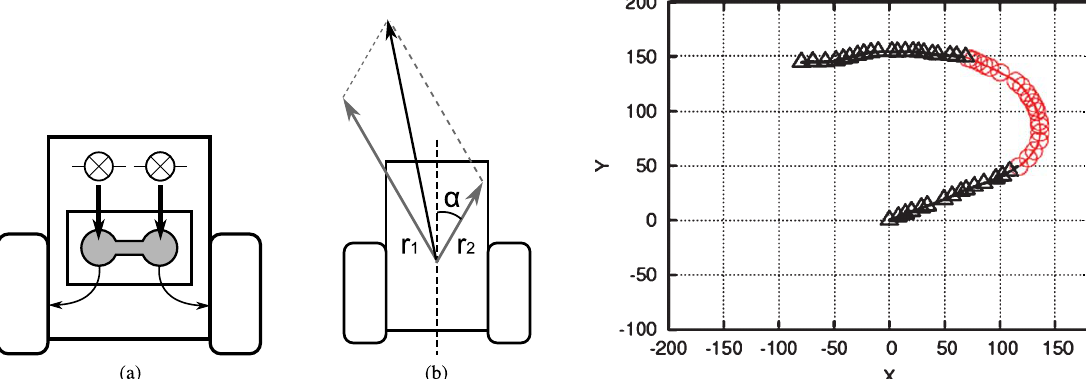
Fig. 6. (a) A schematic diagram of a vehicle driven by Physarum engine. The oscillation amplitudes of the cell determines the wheel rotation speed of the vehicle. Light illumination onto each well of a Phyasrum plasmodium is used to steer the vehicle. (b) The motion of Physarum -driven simulated vehicle. Vehicle’s direction of movement can be represented as addition of vectors (Equation 1).